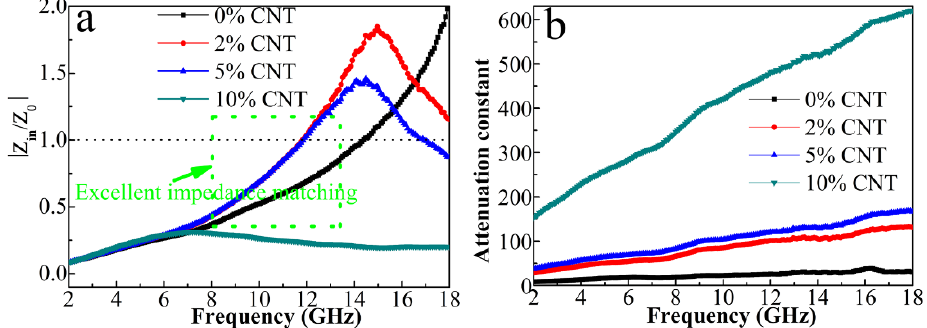
Z /Z and Z /Z and in 0 in 0